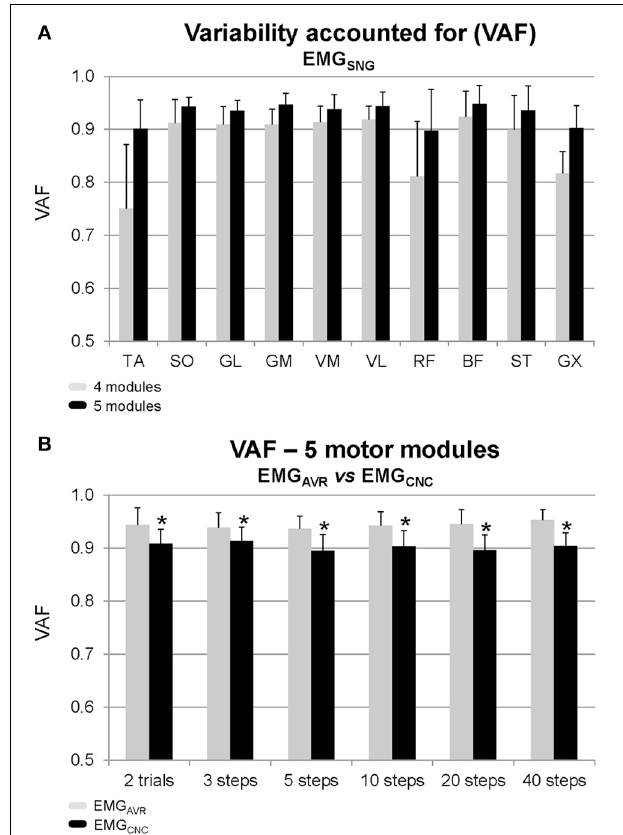
FIGURE 2 | Mean ± SD of the variation accounted for (VAF) from the factorization analysis of individual step cycles (A) by considering to reconstruct the original EMG dataset using four motor modules ( gray bars ) and five motor modules ( black bars ) from single step cycles (EMG SNG ). (B) The VAF from the reconstruction of original EMG datasets by using five motor modules from averaged EMG (EMG AVR , gray bars ) and from concatenated (EMG CNC , black bars ) in different amounts of step cycles. ∗ Denotes significant difference in relation to EMG AVR ( p < 0 .